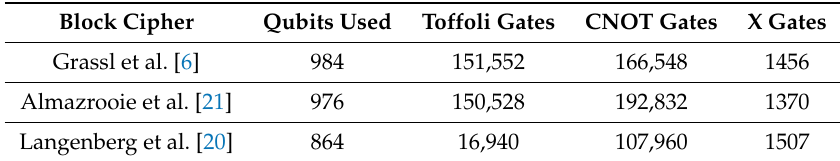
Table 8. Quantum resources to implement